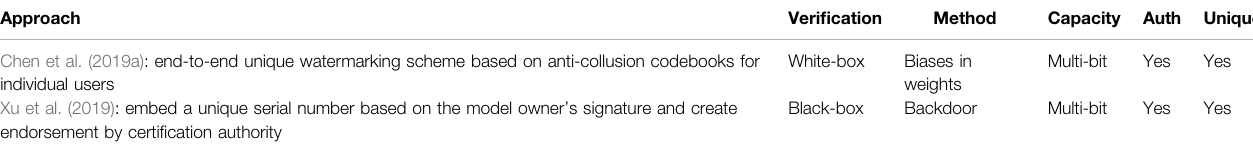
TABLE 5 | Techniques to generate unique watermarks that can be veri fi ed by querying a trigger dataset. Approach Veri fi